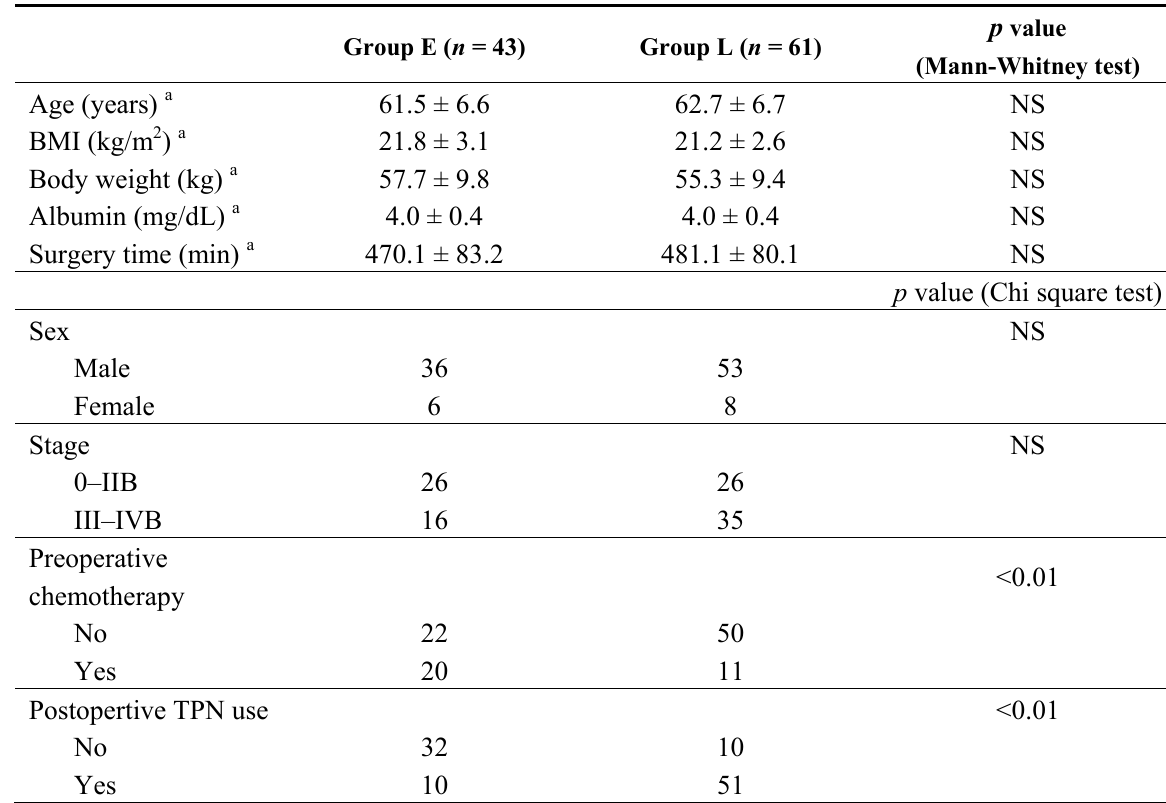
Table 1. Pre- and Perioperative Clinical Features: Early versus Late Enteral Nutrition (EN) ( n =